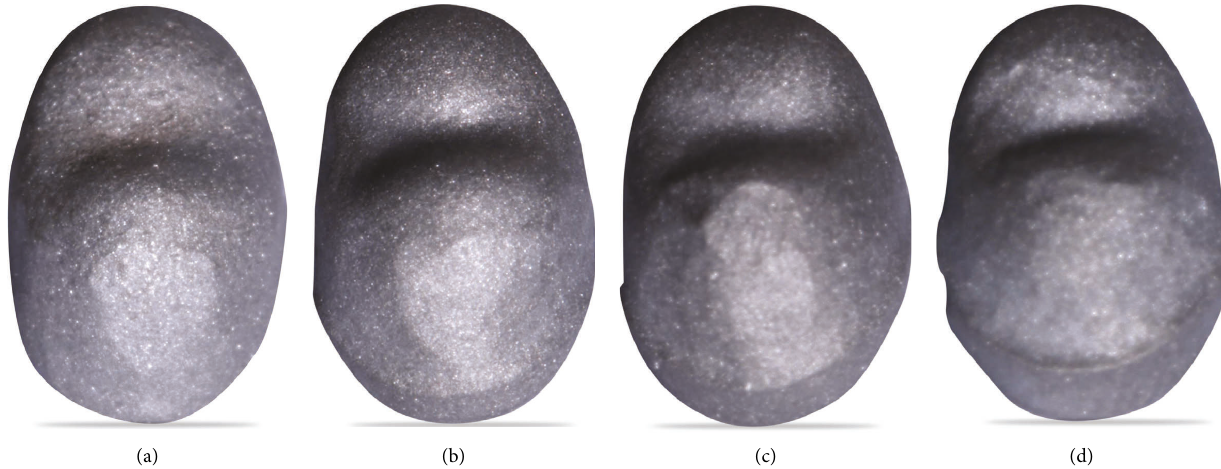
Figure 4: (a) Metal coping with 0mm palatal metal collar in height or collarless. (b) Metal coping with 1.0mm palatal metal collar in height. (c) Metal coping with 1.5mm palatal metal collar in height. (d) Metal coping with 2.0mm palatal metal collar in height.